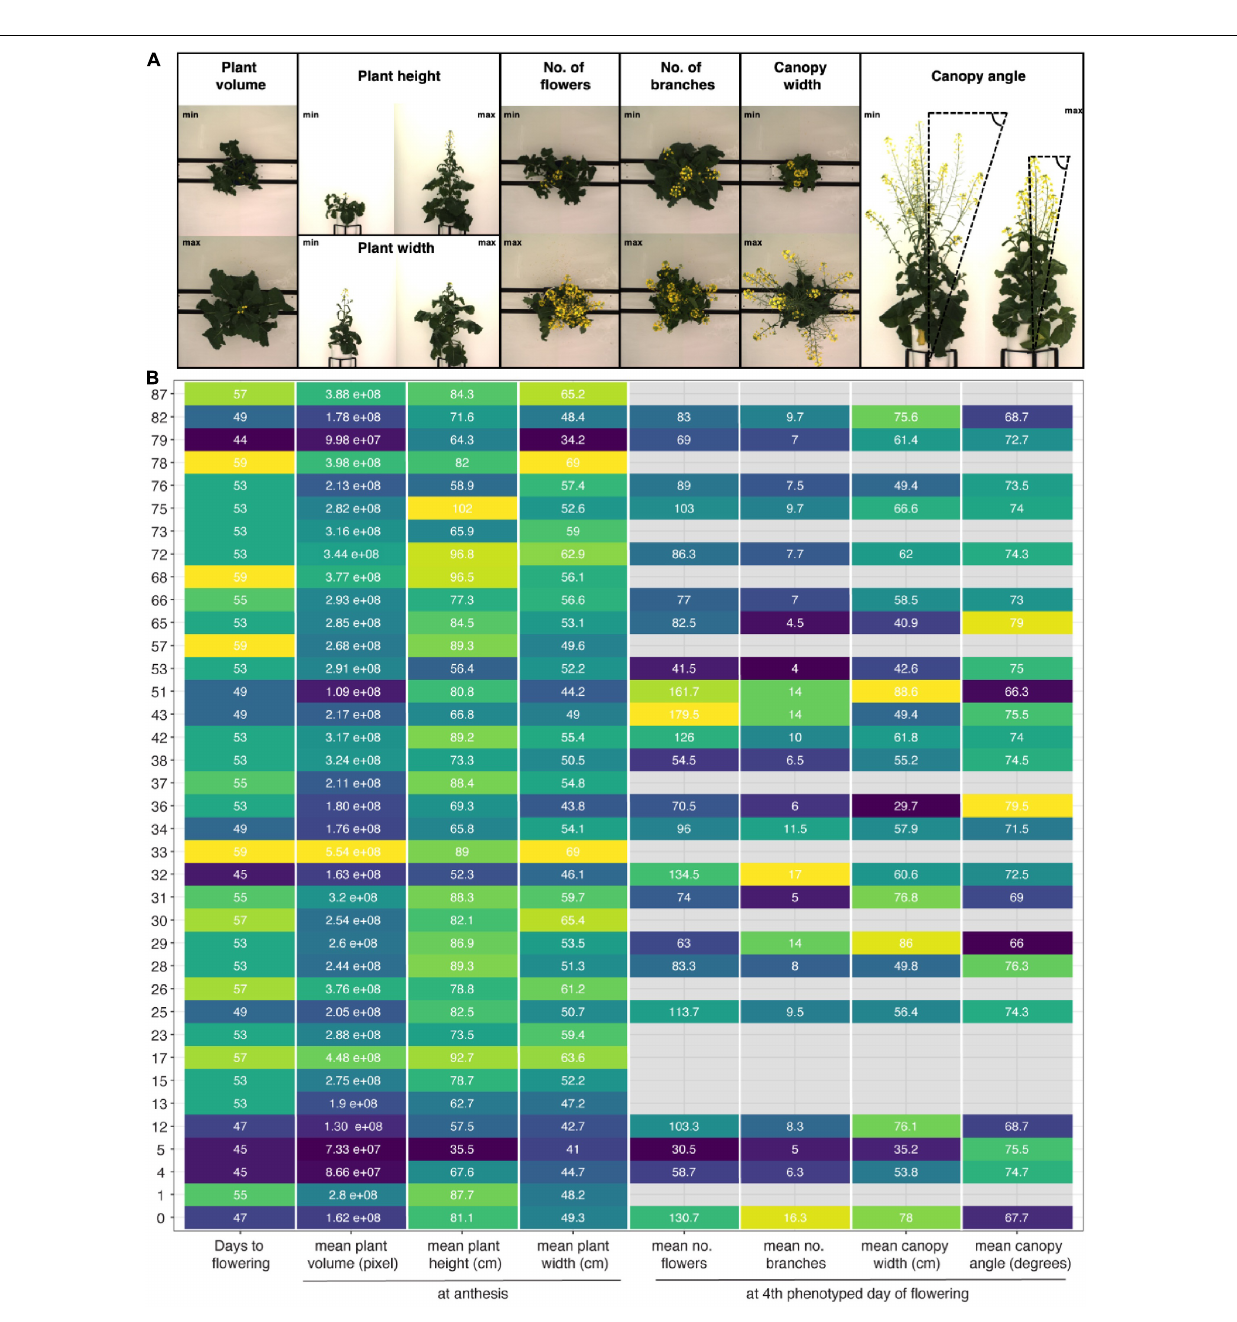
the convex hull area (top view), total number of plant pixels (top view), (cid:49) convex hull (top view), plant height and width, (cid:49) plant height and (cid:49) plant width, ExG, and number of raceme